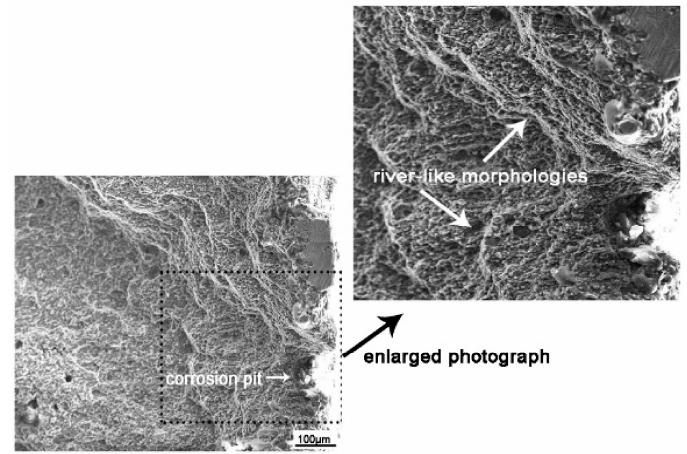
Figure 14. Fracture morphology of corrosion fatigue source.